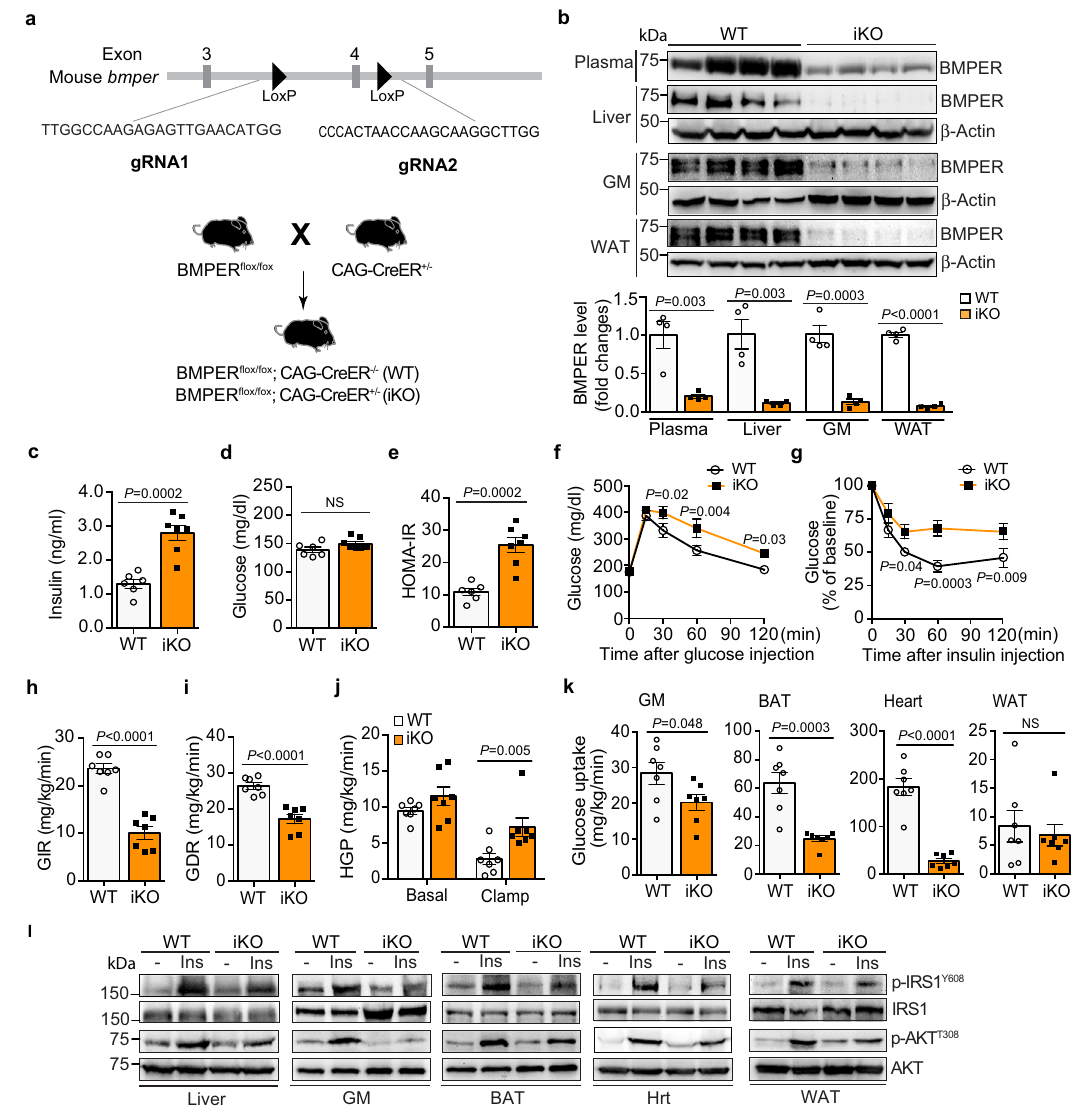
Fig. 1 BMPER depletion causes mice to develop hyperinsulinemia, glucose intolerance, and insulin resistance. a The generation of the BMPER iKO mouse model. The gRNA-guided CRISPR/Cas9 strategy was used for targeted deletion of bmper gene. b BMPER depletion was examined with Western blotting. c – e Fasted insulin and glucose, HOMA-IR. f , g Glucose and insulin tolerance tests. h Glucose infusion rate (GIR). i Glucose disposal rate (GDR). j , k Hepatic glucose production (HGP; j ) and glucose uptake in peripheral tissues ( k ) were analyzed with hyperinsulinemic-euglycemic clamps. l Insulin signaling was blunted in BMPER iKO mice. Insulin (Ins, 0.5h) was injected ( i.p .) into BMPER iKO and WT mice. Indicated tissues were used for Western blotting. GM gastrocnemius muscle, BAT brown adipose tissue, WAT white adipose tissue, Hrt heart. WT, BMPER fl ox/ fl ox ; CAG-CreER – / – . iKO, BMPER fl ox/ fl ox ; CAG-CreER + / – . n = 4 mice ( b ), 6 mice ( c – e WT), 7 mice ( c – e iKO), 7 mice ( f , h – k ) and 5 mice ( g ). Data are presented as mean values±SEM. NS not signi fi cant. Analysis was